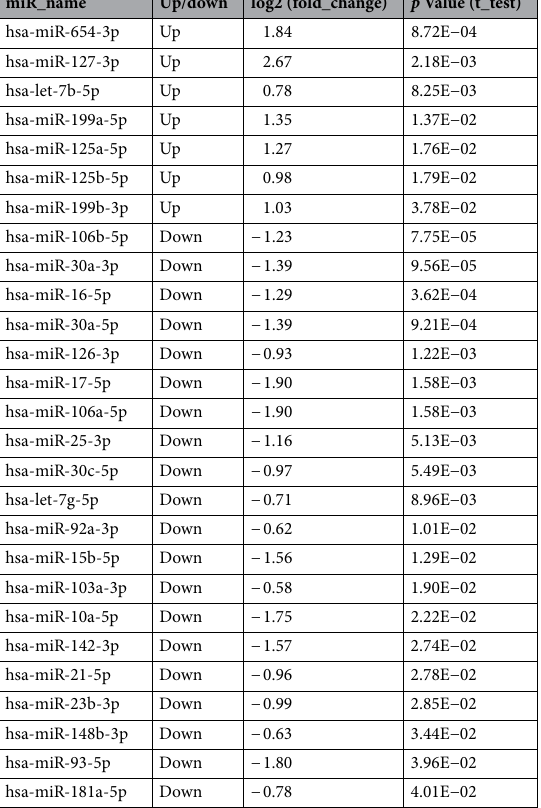
Table 1. List of differentially expressed miRNAs. There were 27 miRNAs in the high-expression group that displayed differential expression (up/down) in the KS and control samples. From the 166 miRNAs that showed differential expression, we showed only those that were either highly upregulated- or downregulated and listed them according to